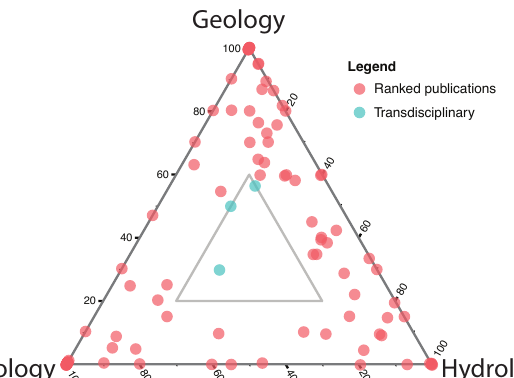
Figure 2. Depiction of the disciplinary focus of 147 journal arti- cles using lidar. Articles were qualitatively ranked based on their applicability to geomorphological, hydrological, and/or ecological process understanding. Articles in the center are examples of trans- disciplinary lidar applications, with those shown in blue used as exemplars in the